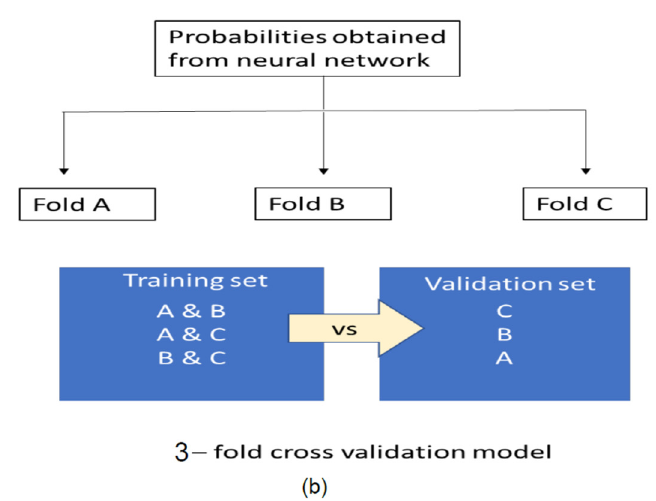
Figure 3. A schematic diagram to illustrate the k-fold cross-validation technique adopted in VOC data synthesis ( a ) steps in model construction ( b ) 3-fold cross-validation model. data synthesis ( a ) steps in model construction ( b ) 3-fold cross-validation